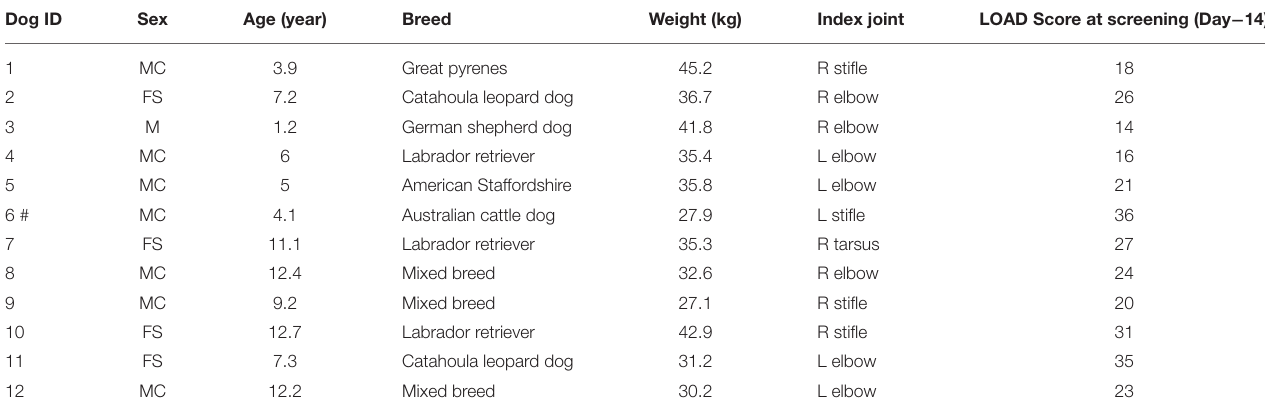
TABLE 2 | Characteristics of each dog enrolled into Part A